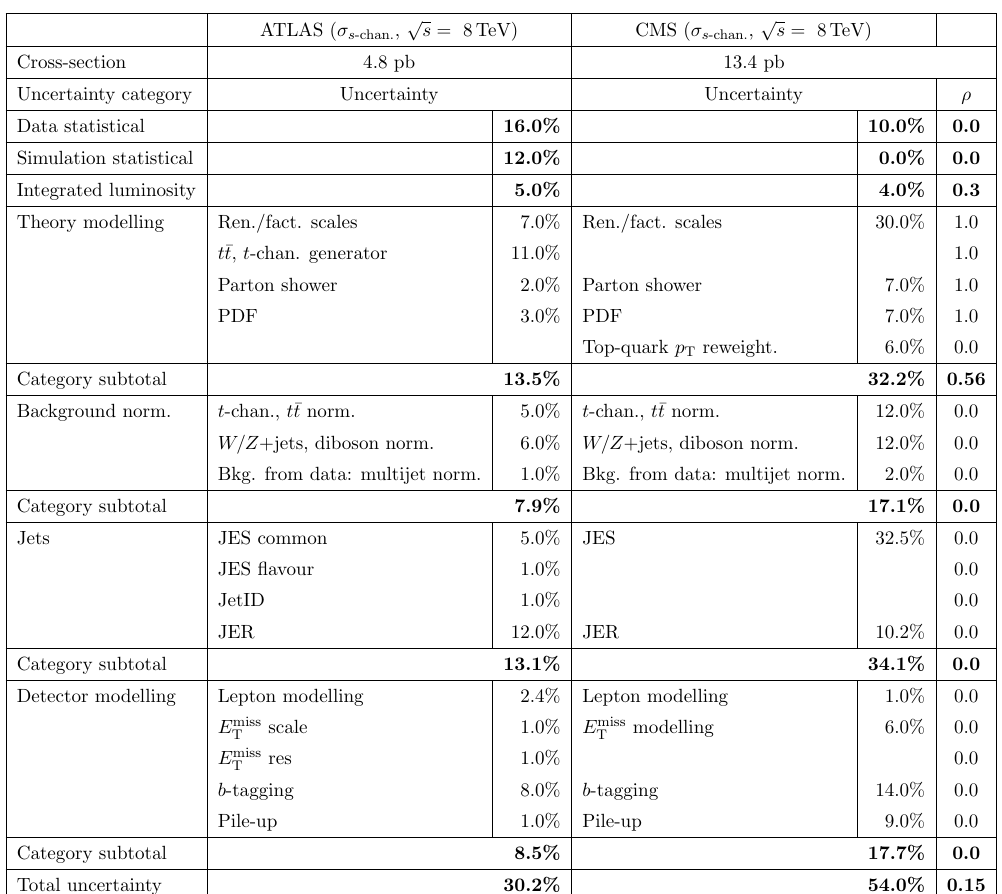
Table 13 . Measured cross-sections, uncertainty components, their magnitudes (relative to the indi- vidual measurements) and the correlation ( (cid:26) ) between the ATLAS and CMS (cid:27) s -chan. measurements at p s = 8 TeV. Uncertainties in the same row can be compared between experiments, as detailed in the text. The naming conventions follow those of the corresponding